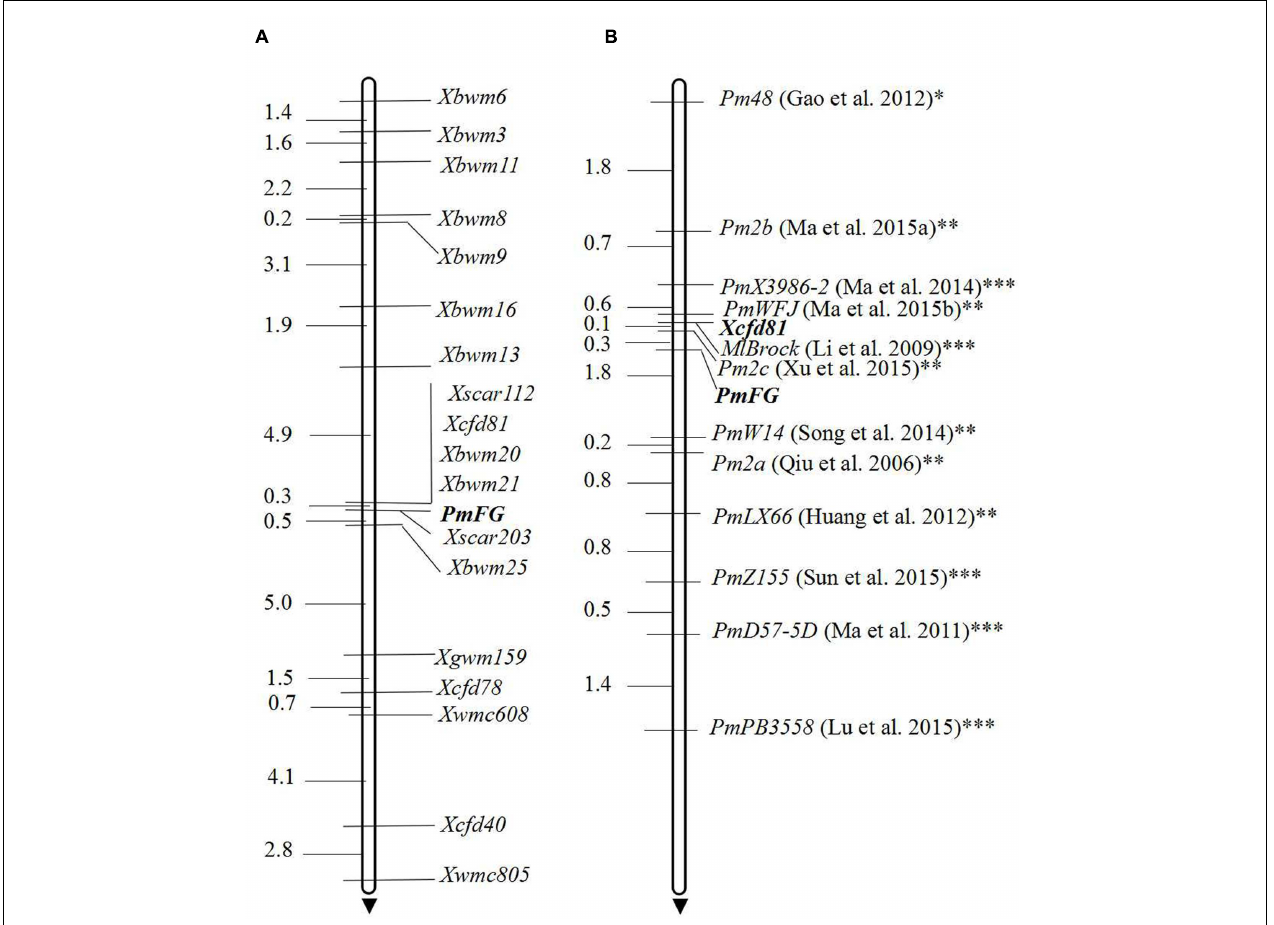
FIGURE 3 | Linkage map of PmFG using the F 2 : 3 families of FG-1 × Mingxian 169 (A) and its locus comparison with the documented Pm genes on chromosome arm 5DS using PmFG as point zero with the genetic distances marked off from it based on the anchoring marker locus Xcfd81 (B). Genetic distances in cM are showed to the left. ∗ , closely linked with Pm2 ; ∗∗ , allelic with Pm2 ; ∗∗∗ , allelic relationship with Pm2 was not confirmed.